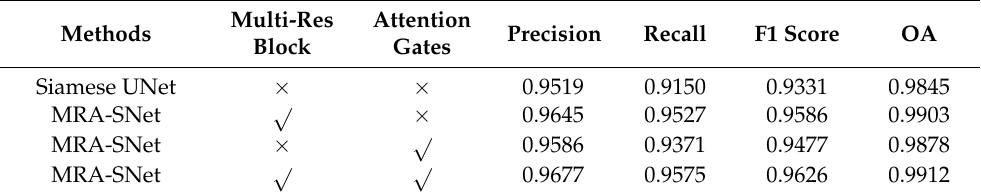
Table 2. Results of ablation experiments with the Multi-Res block and the Attention Gates module on the CDD